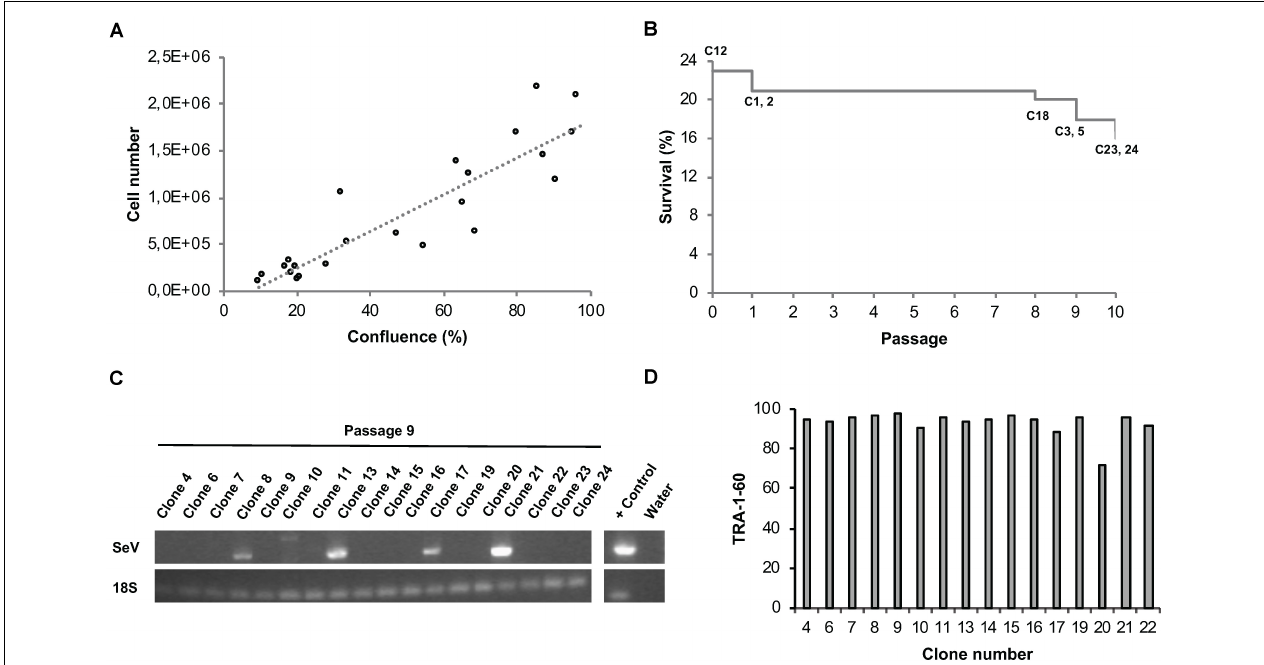
FIGURE 7 | Automated parallel expansion of hiPSC clones. Human iPSC clones were automatically expanded in parallel in a single 24-well plate based on well-specific confluence values. (A) To establish a confluence-based readout method for automatic determination of the dilution ratio, the measured confluence values were correlated with the cell number using two exemplar hiPSC control lines. hiPSCs were plated at low density in 6-well plates, confluence values as well as cell numbers were determined daily. Linear regression; R 2 = 0.81). (B) Survival plot of automatically expanded clones after 10 consecutive passages. Non-surviving clones are indicated. Passage 0 refers to the automated isolation of 24 primary clones using the CellCelector system (clone 12 was lost before passage 1). (C) RT-PCR analysis for detection of residual Sendai virus at passage 9. (D) TRA-1-60 flow cytometry analysis of expanded hiPSC clones at passage 10 after